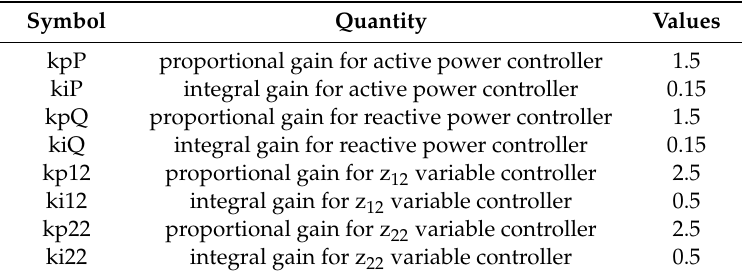
Table A2. Parameters of PI regulators in reference